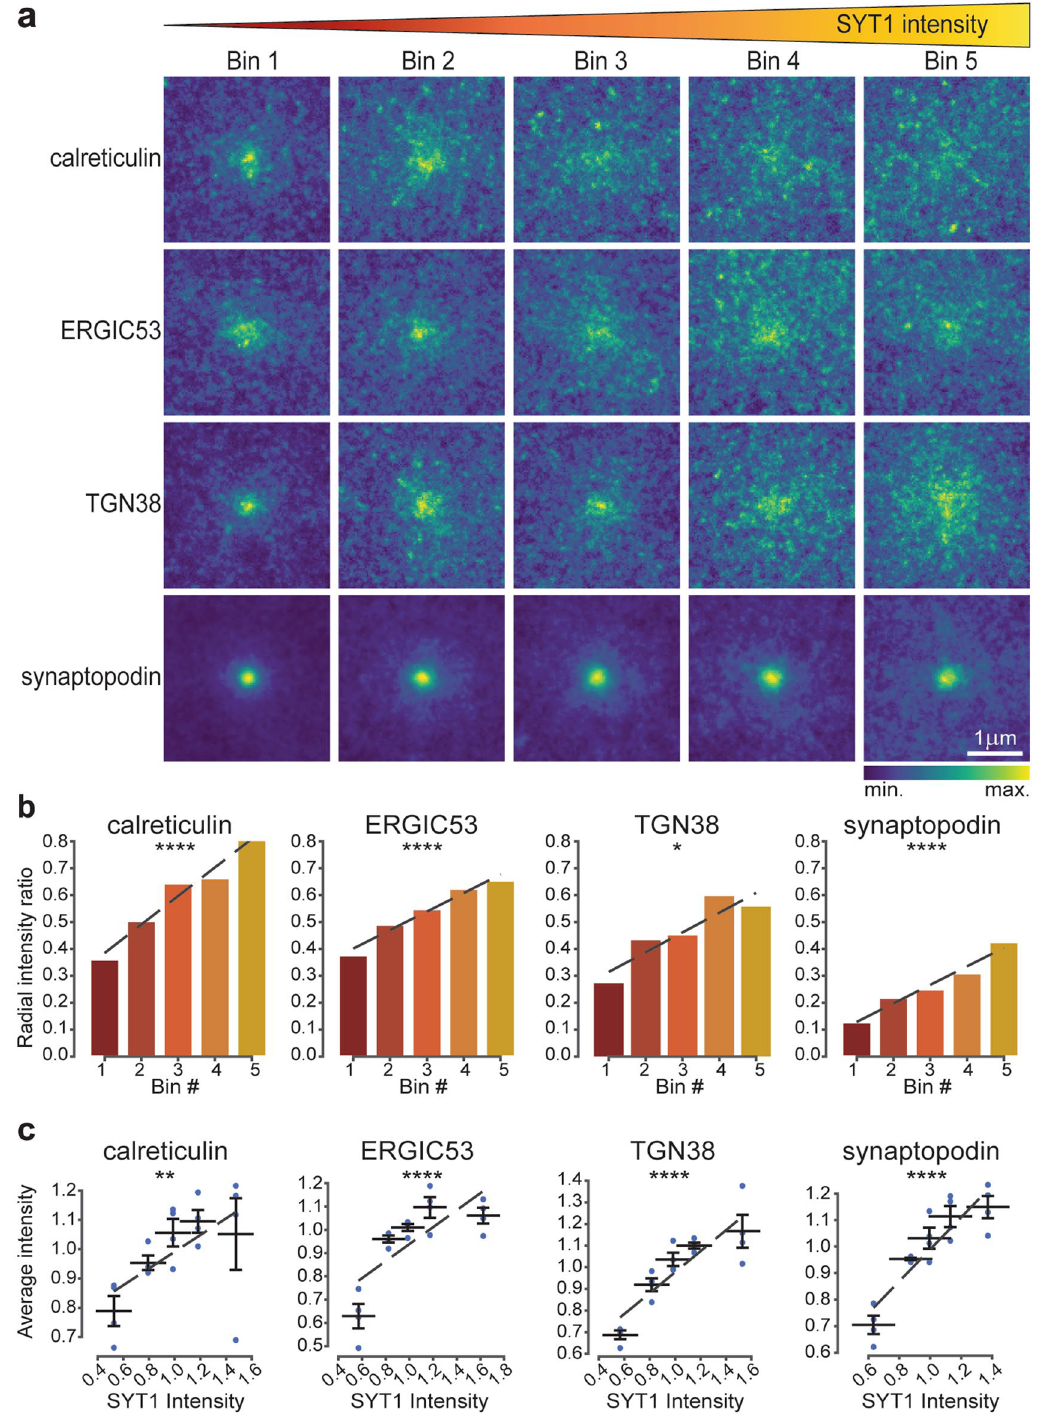
Figure 4. Correlation between pre-synaptic activity and secretory pathway elements. ( a ) Average images for the different POIs based on five SYT1 intensity bins displayed in 3 × 3 µm crops around the synaptic site. Bin 1 has the lowest SYT1 intensity and bin 5 the highest. ( b ) Ratio between signal intensity at the periphery and at the centre of the average images calculated based on radial analysis. ( c ) Correlation of SYT1 intensities and the average intensities of the POIs. Dashed lines are linear fits. All data were collected from four independent experiments. * = p < 0.05, ** = p < 0.01, *** = p < 0.001, **** = p < 0.0001, and ns. = non-significant. Whiskers represent S.E.M. Numbers of synapses per bin and Spearman’s rho are listed in Supplementary Table